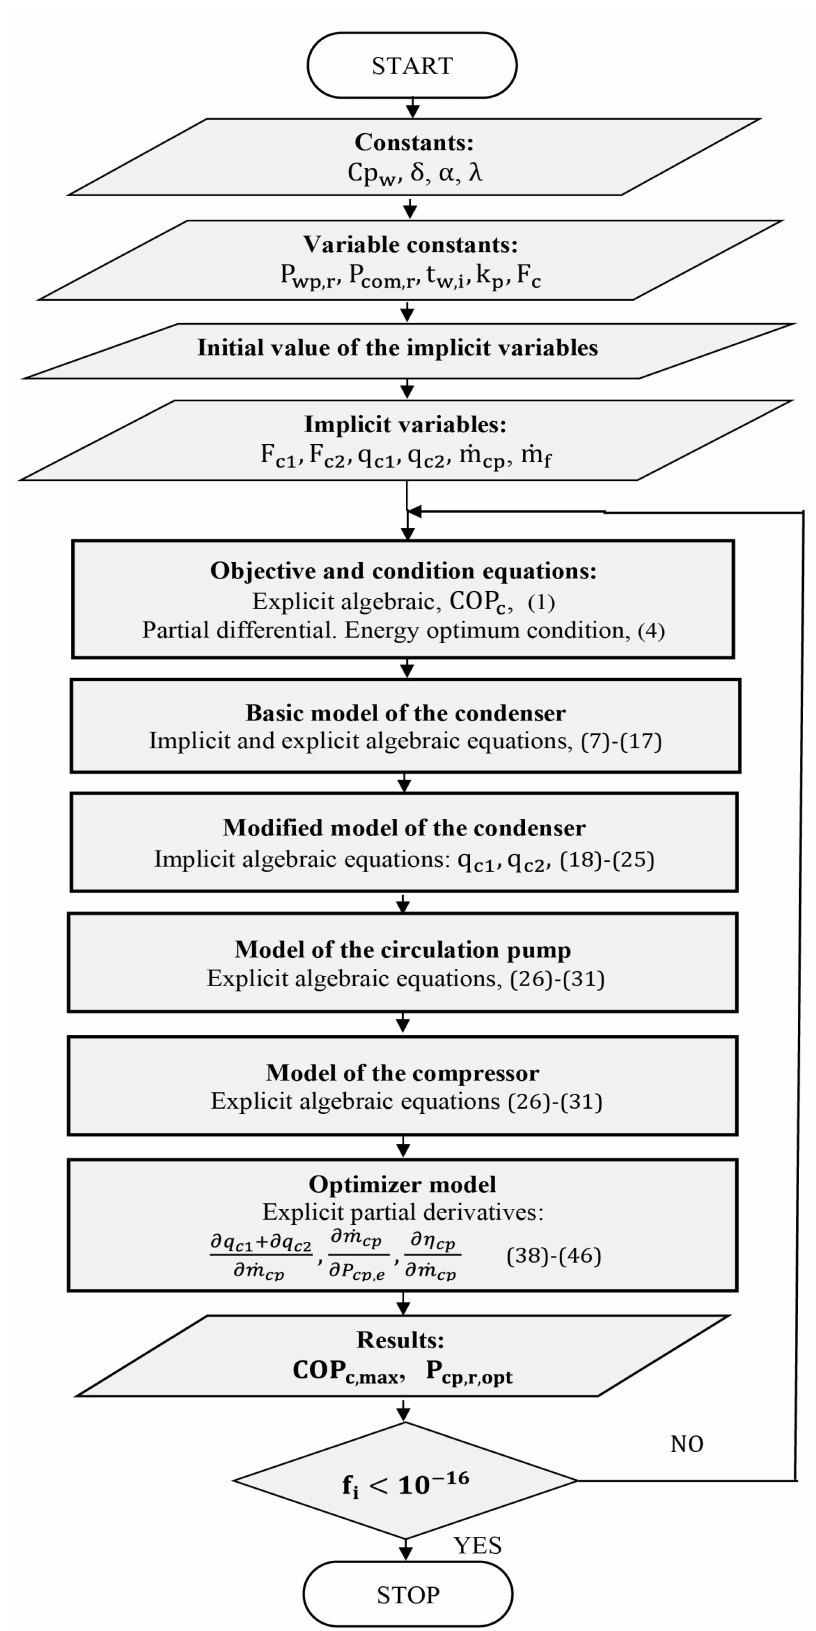
Figure 3. Algorithm of the energy optimization